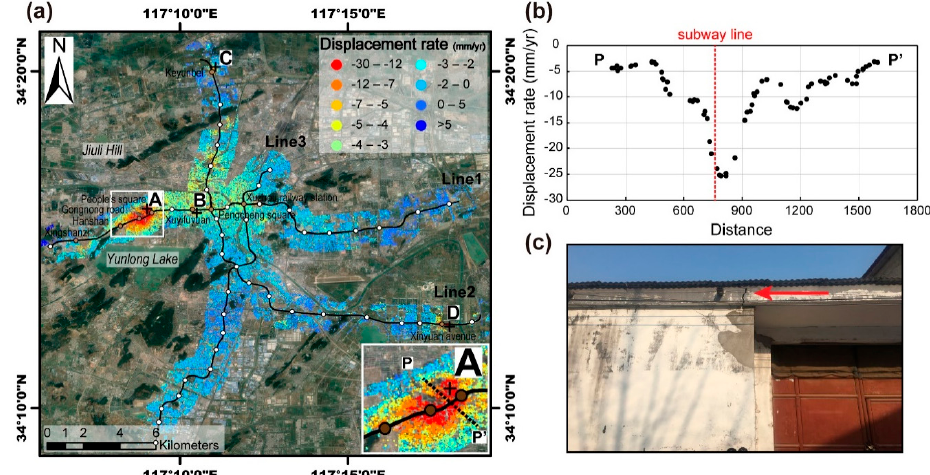
Figure 8. ( a ) Displacement rate map (2015–2018) within a 1 km-wide bu ff er along the subway lines, extracted from Figure 6. All circles are subway station locations, among which the brown circles with station names indicate those discussed in the paper. The inset in the bottom-right corner is an enlarged map of the area marked by the white rectangle. Points A, B, C and D are discussed in the paper and are marked by black crosses. The map conventions are the same as in Figure 4. ( b ) The profile of P-P’ in the inset of ( a ). ( c ) Damages to a local house caused by land subsidence. Remote Sens. 2019 , 11 , x FOR PEER REVIEW